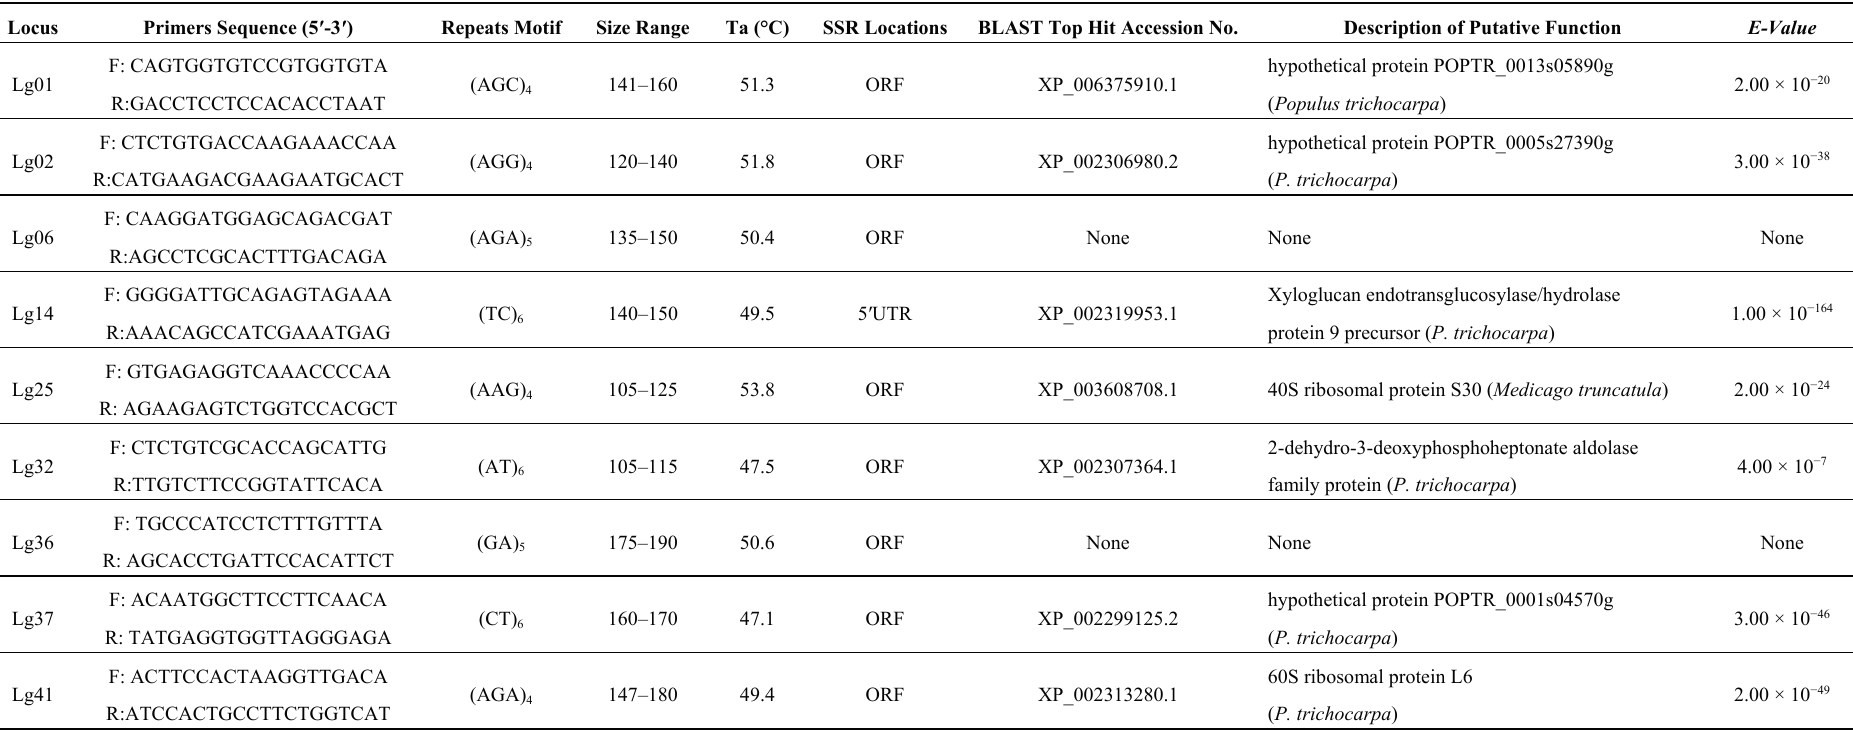
Table 1. Characteristics of 10 polymorphic EST-SSR markers from L. gmelinii